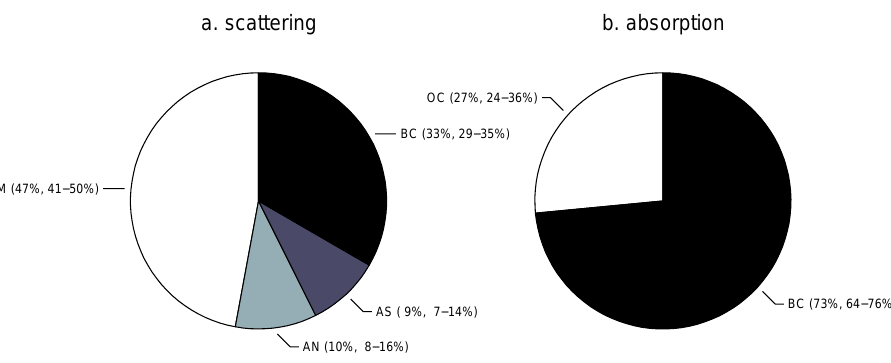
Fig. 4. Apportionment of (a) scattering and (b) absorption at a wavelength of 550nm in extratropical southern Africa. Shown are the median percent contributions (with the interquartile range) of organic matter (OM), black carbon (BC), ammonium nitrate (AN), and ammonium sulfate (AS).